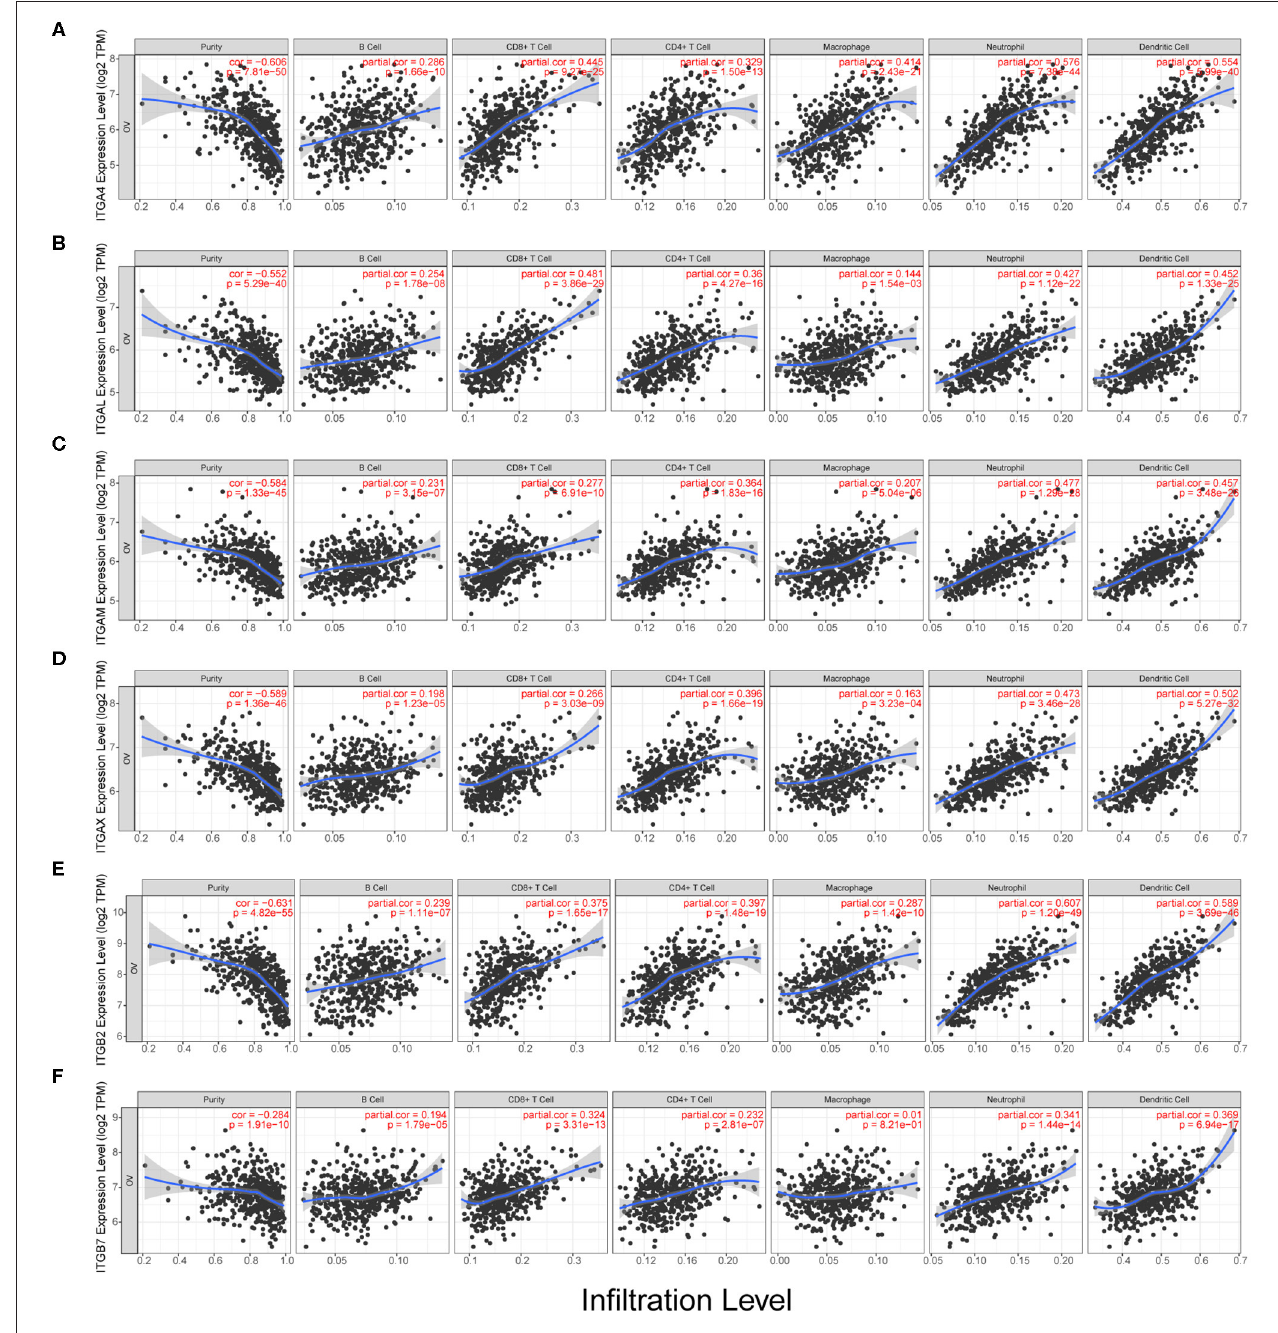
FIGURE 5 | Correlation analysis of integrin genes and infiltration levels of immune cells in OC tissues. (A) Correlation of ITGA4 mRNA and infiltration levels. (B) Correlation of ITGAL mRNA and infiltration levels. (C) Correlation of ITGAM mRNA and infiltration levels. (D) Correlation of ITGAX mRNA and infiltration levels. (E) Correlation of ITGB2 mRNA and infiltration levels. (F) Correlation of ITGB7 mRNA and infiltration levels.